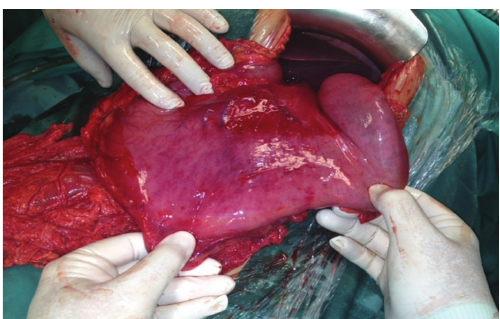
Figure 3: The untwisted distended stomach with ischemic mucosal lesions.